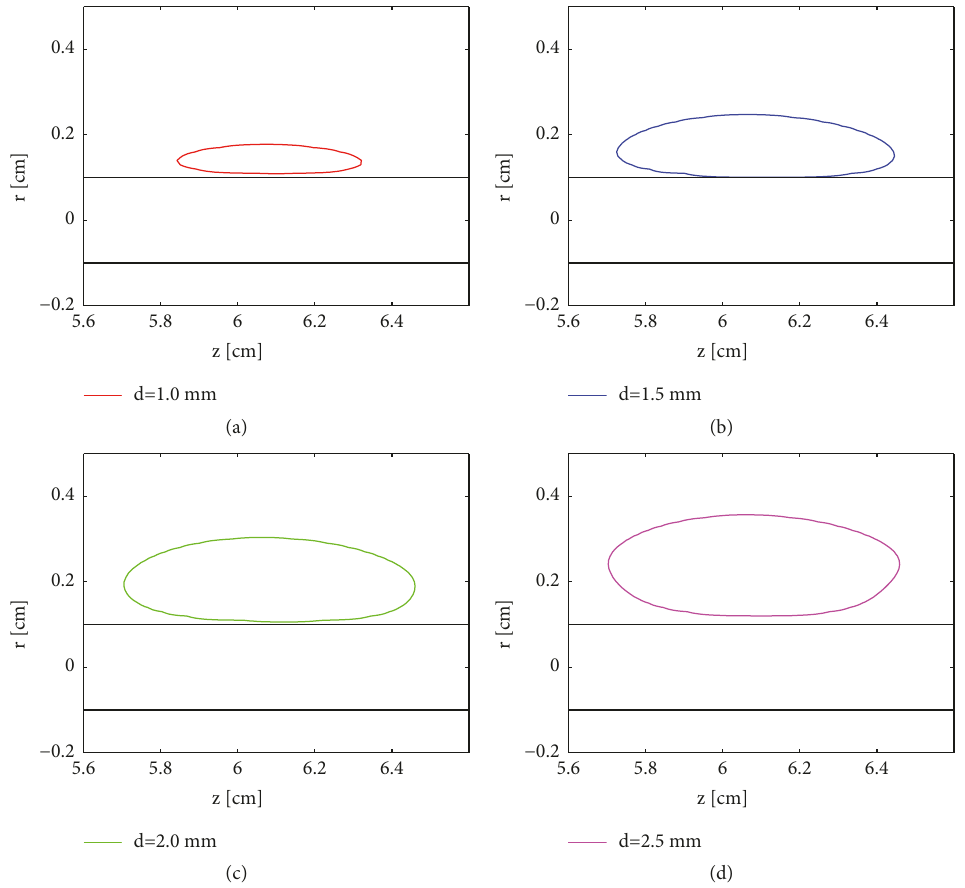
Figure 7: Thermal lesion region in space 𝑟, 𝑧 ∈ Ω with different distance 𝑑 for 𝑝 0 = 1.5 × 10 5 𝑝𝑎 , 𝑟 0 = 1 𝑚𝑚 , 𝜏 = 1.756 𝑠 , 𝑢 𝑎 V 𝑒 = 5𝑐𝑚/𝑠 , 𝑓 = 1 𝐻𝑧 , 𝑓𝑎𝑐 = 0.5 , 𝑡 = 1𝑠 . 𝑝 ℎ